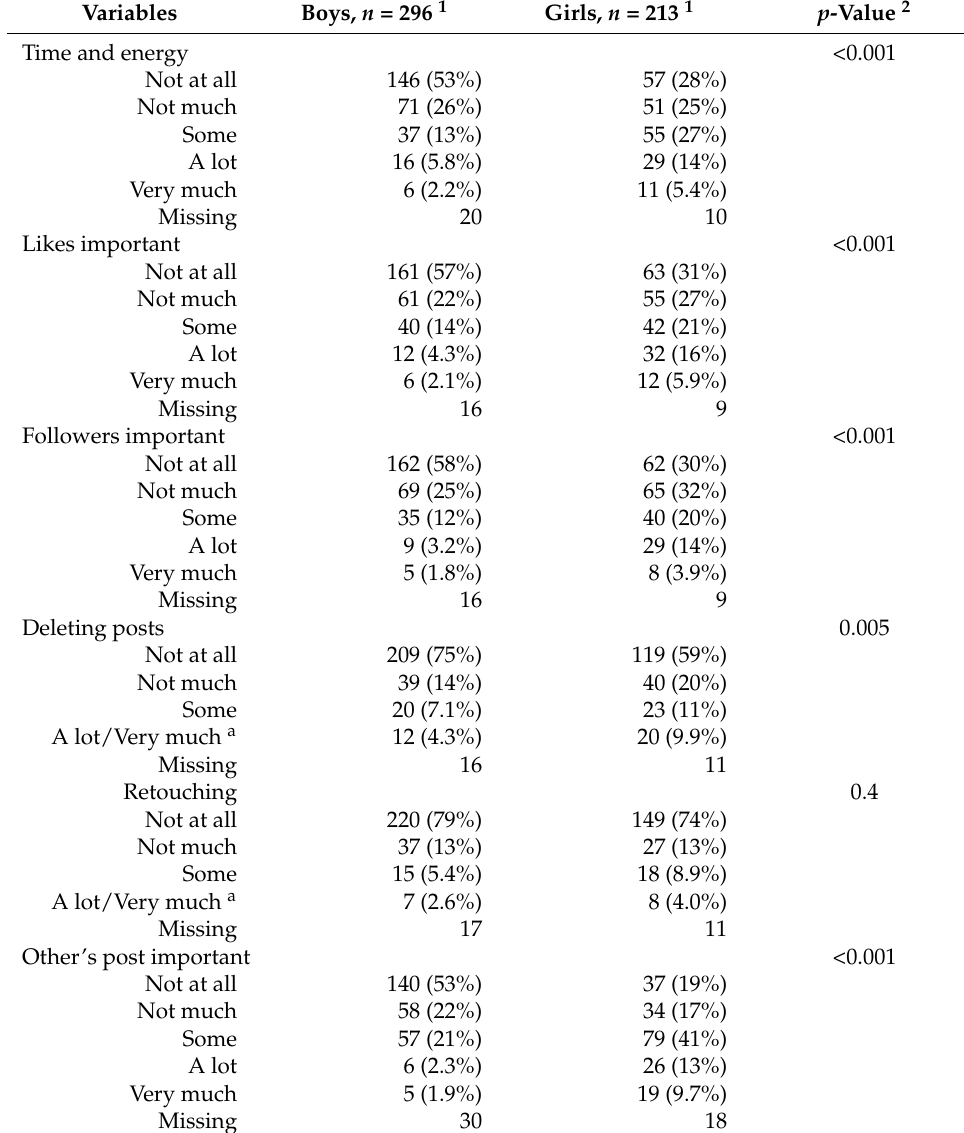
Table 1. Description of included study variables across gender. n =